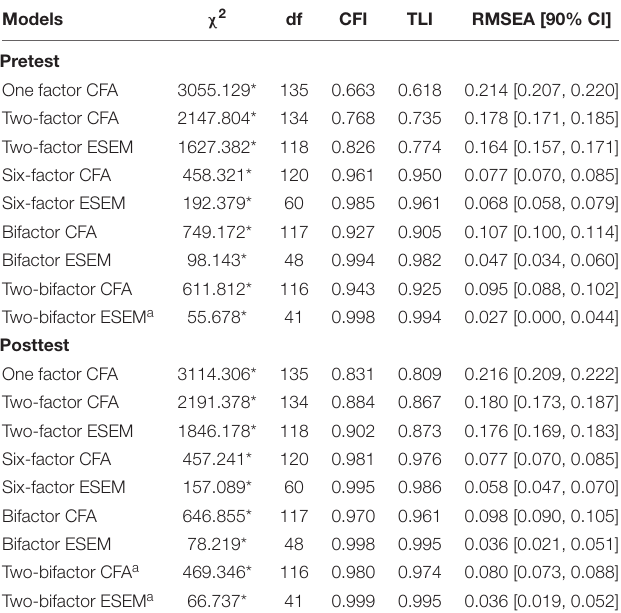
TABLE 7 | Goodness-of-fit indices for the estimated solution for the Japanese version of the State Self-Compassion Scale in Study 2.